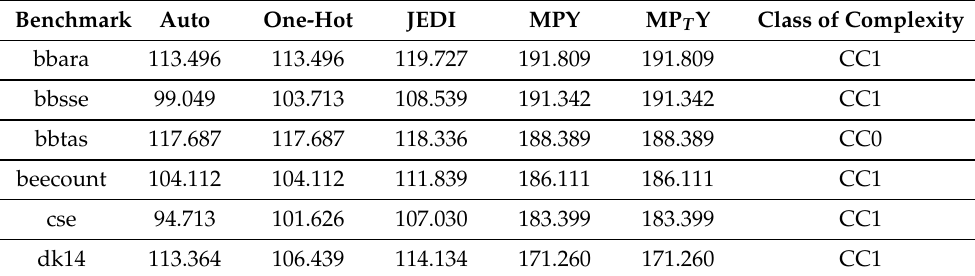
Table 15. Experimental results (the frequencies for classes CC0-CC1,